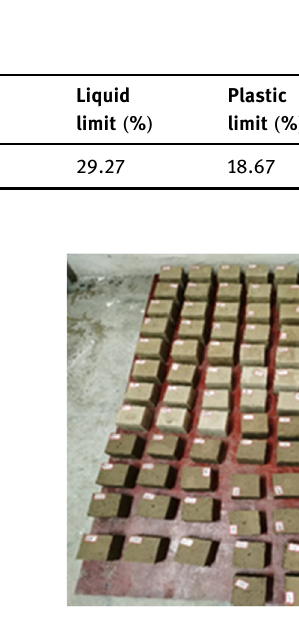
Figure 4: Image of samples produced for